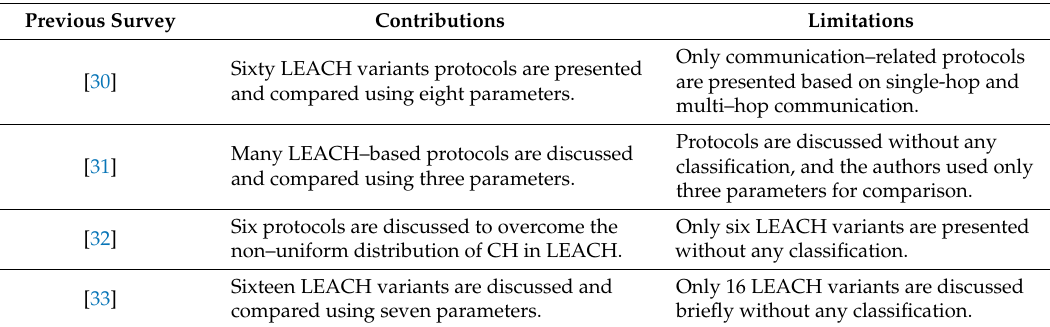
Table 3. Comparison of previous surveys on leach-based routing protocols.